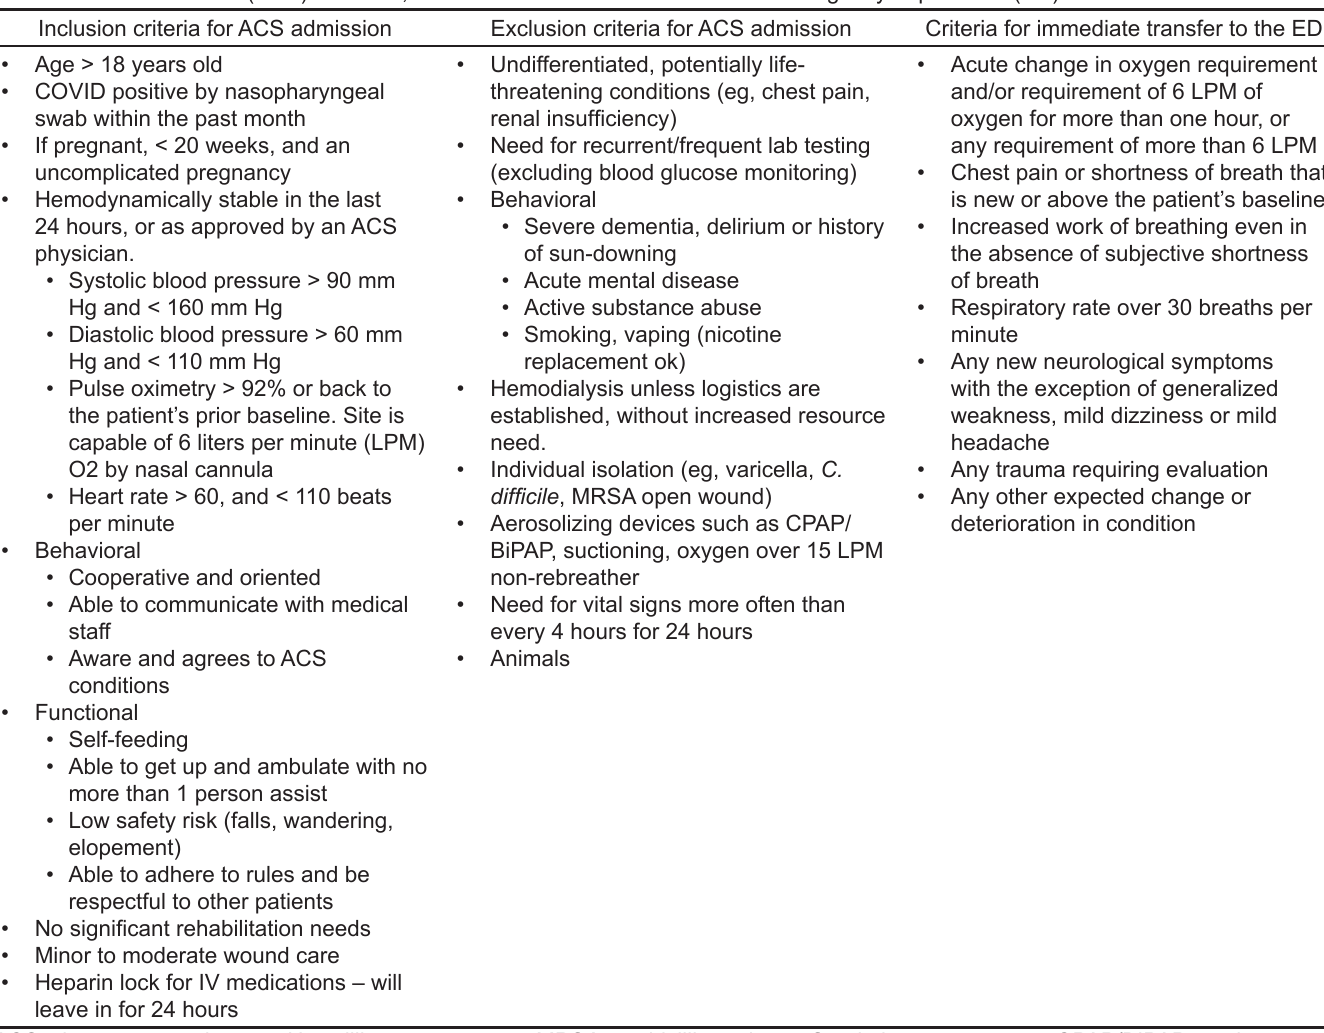
Table. Alternate care site (ACS) inclusion, exclusion and immediate transfer to emergency department (ED)